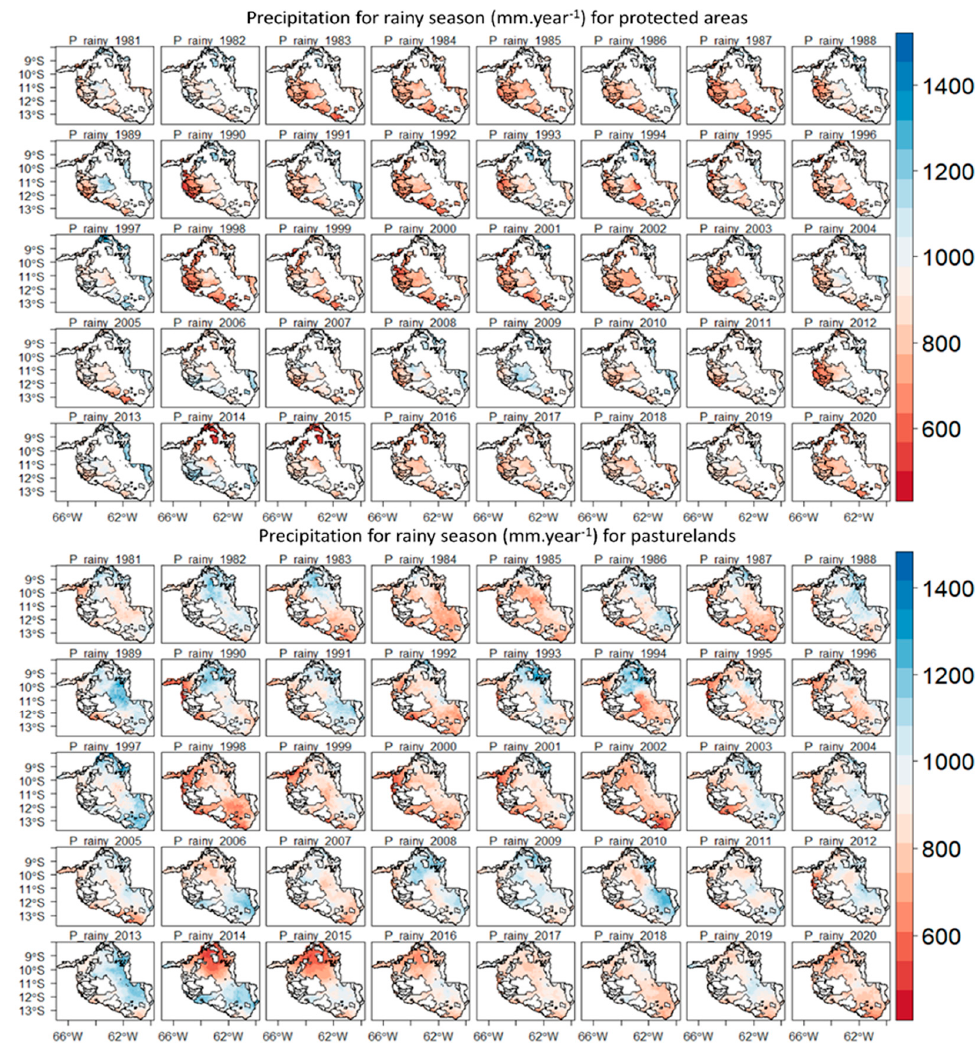
Figure 9. Spatialization of yearly accumulated rainfall for the rainy season in Rondônia for the years 1981 to 2020 using CHIRPS data for protected and pasture areas.